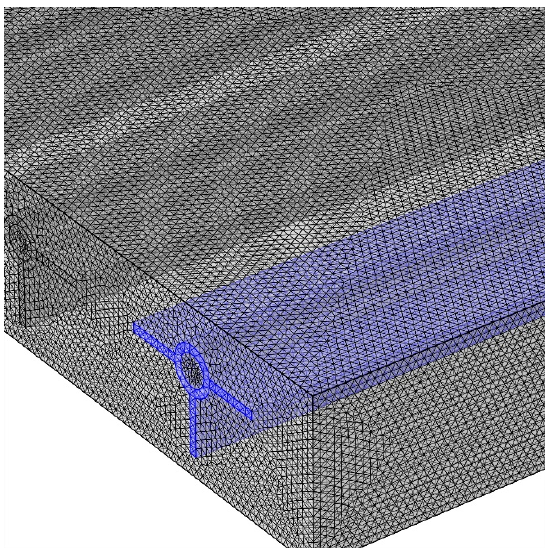
Figure 2. Meshed model of the panel and pipes. Table 3. Average panel temperature in different grids for a velocity of 0.1 cm/s.